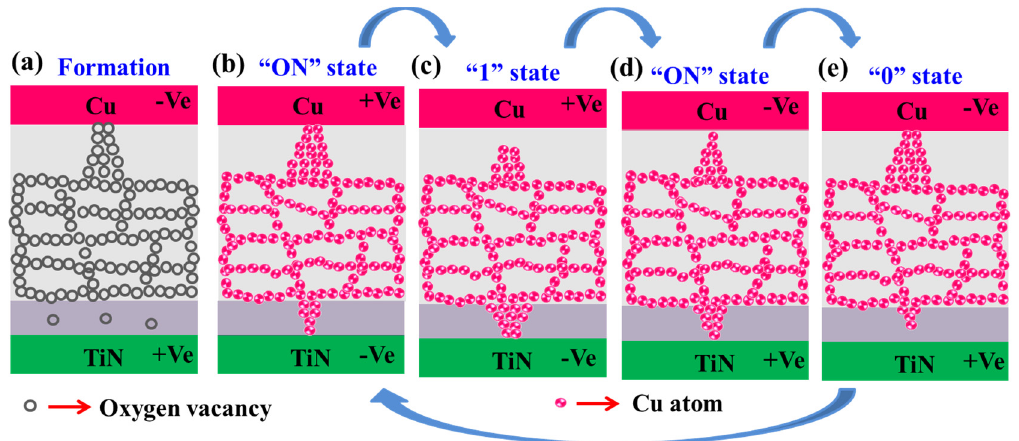
Figure 9. Schematic demonstration of Cu filament formation/dissolution of CRS characteristics for the Al/Cu/GdO x /Al 2 O 3 /TiN structure. ( a ) Oxygen formation under a negative bias on the TE of a pristine device, ( b ) “ON” state at >V SET1 , ( c ) “1” state at >V RESET2 , ( d ) “ON” state at <V SET2 , and ( e ) “0” state at <V RESET1 . The switching mechanism is due to Cu ions’ migration under controlling an external bias of V RESET1 /V RESET2 and the Cu filament is formed/dissolved at the Cu/GdO x interface and in Al 2 O 3 layer.